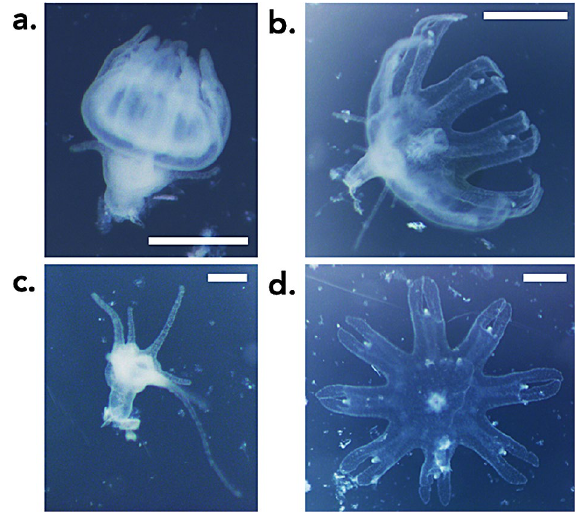
Figure 2. Monodisk strobilation of Aurelia relicta Scorrano et al. 2017 from Mljet (Croatia) observed in co-occurrence with indirect development. Scale bars = 500